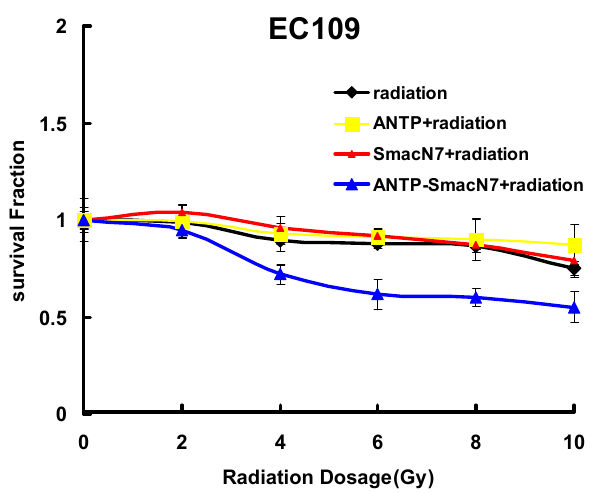
Figure 3. Radiation sensitising effects of ANTP-SmacN7.